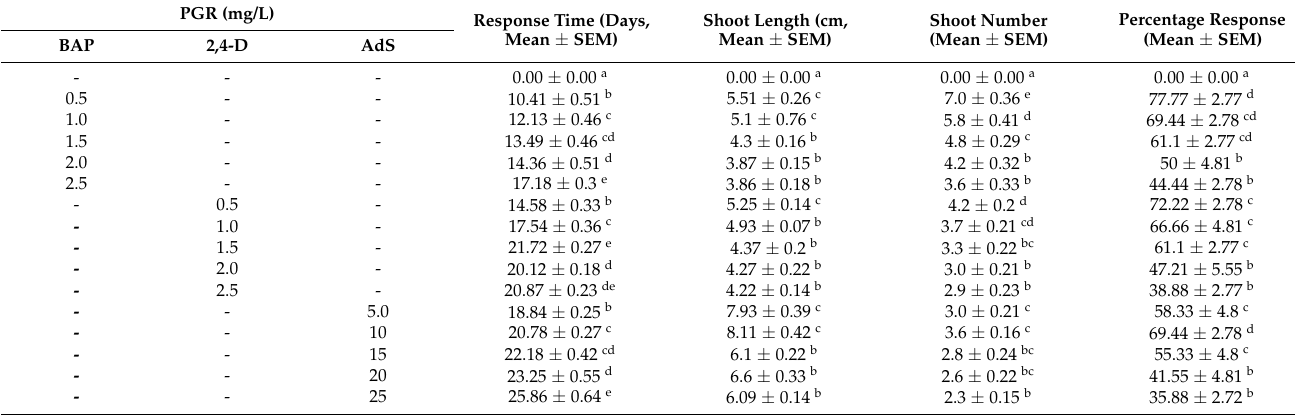
The data were recorded for up to 6 weeks. The data represent the mean value ± SEM (standard error mean) and were found to be statistically operative and significant according to Duncan’s multiple range test (DMRT) at p ≤ 0.05. Mean ± SEM followed by the different letters within each column are significantly different according to DMRT (one-way ANOVA was performed within the same hormone) at p ≤ 0.05. Abbreviations: 2,4-D: 2,4-dichlorophenoxyacetic acid; BAP: 6-benzylaminopurine; and AdS: Adenine